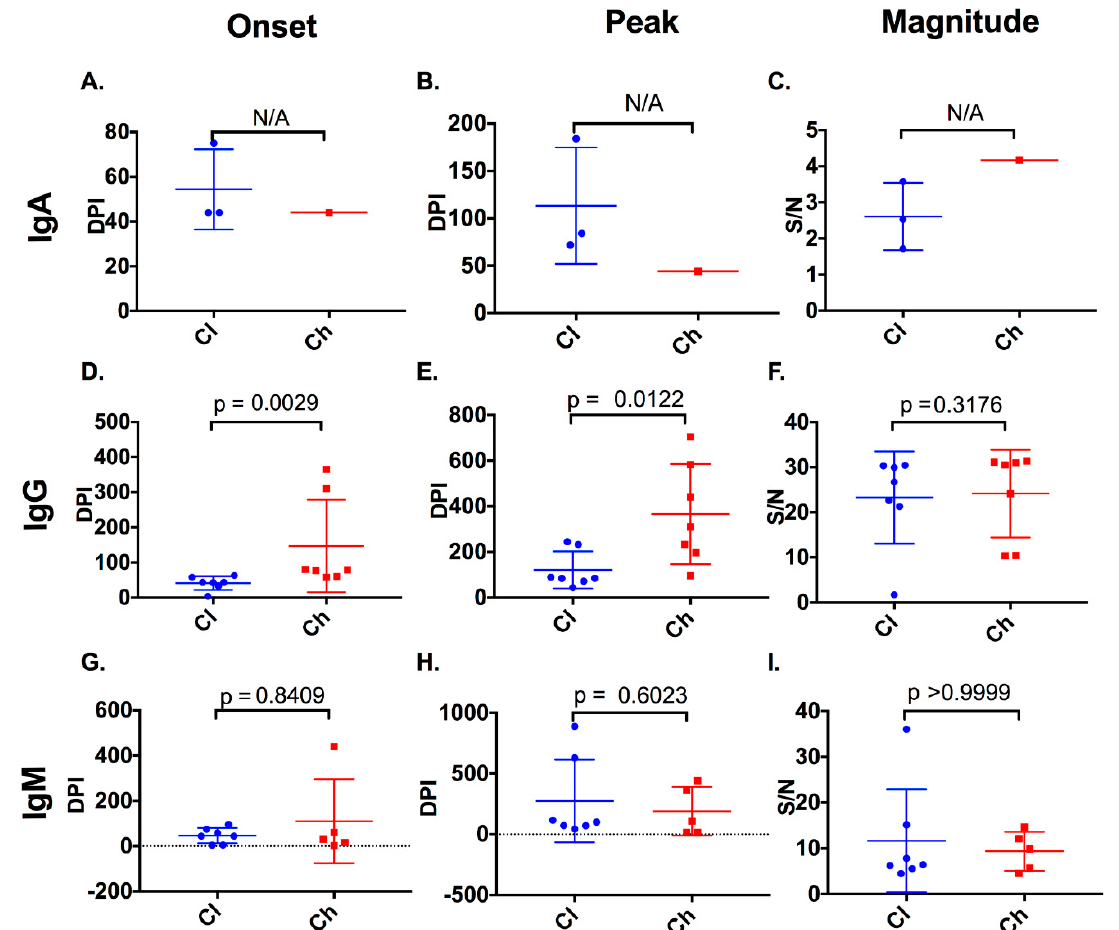
Figure 2. Timing and magnitude of anti-E2 IgA, IgG, and IgM responses in clearer and chronic progressor subjects. The timing (days post infection (DPI)) and magnitude (signal / noise (SN)) of anti-E2 IgA, IgG, and IgM responses were assessed in clearers and chronic progressors for the first detectable anti-E2 IgA ( A ), IgG ( D ), and IgM ( G ) responses, the timing of the peak anti-E2 IgA ( B ), IgG ( E ), and IgM ( H ) responses, and the magnitude of the peak anti-E2 IgA ( C ), IgG ( F ), and IgM ( I ) responses. Statistical significance was not applicable (N / A) for anti-E2 IgA responses, because of a lack of reactive samples in chronic progressors.